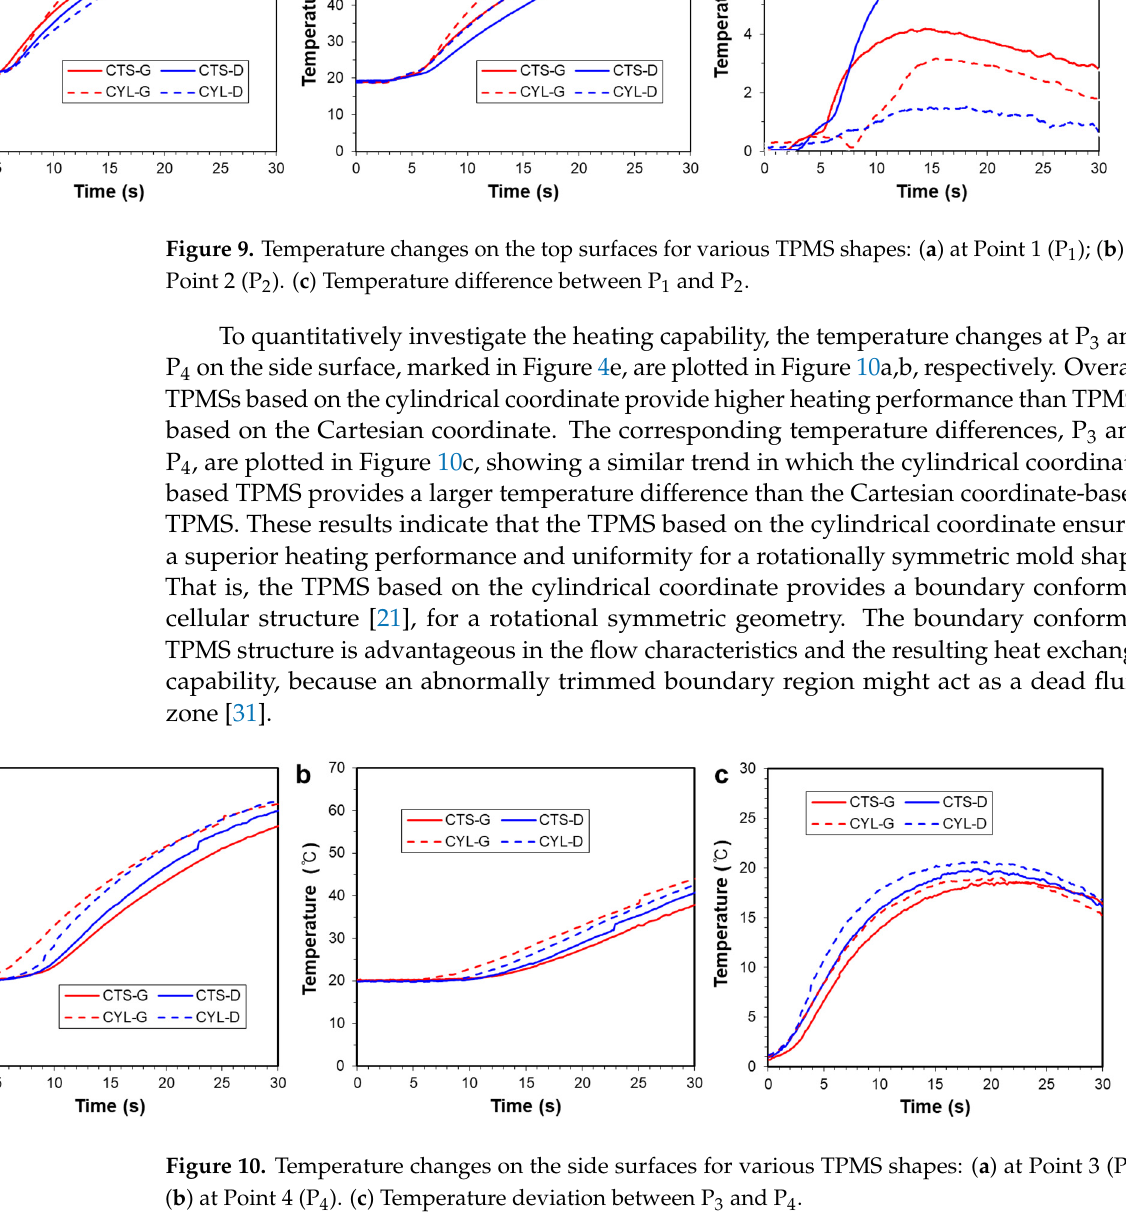
Figure 8. Results of heating experiments for four TPMS structures: ( a ) Change of the side tempera-